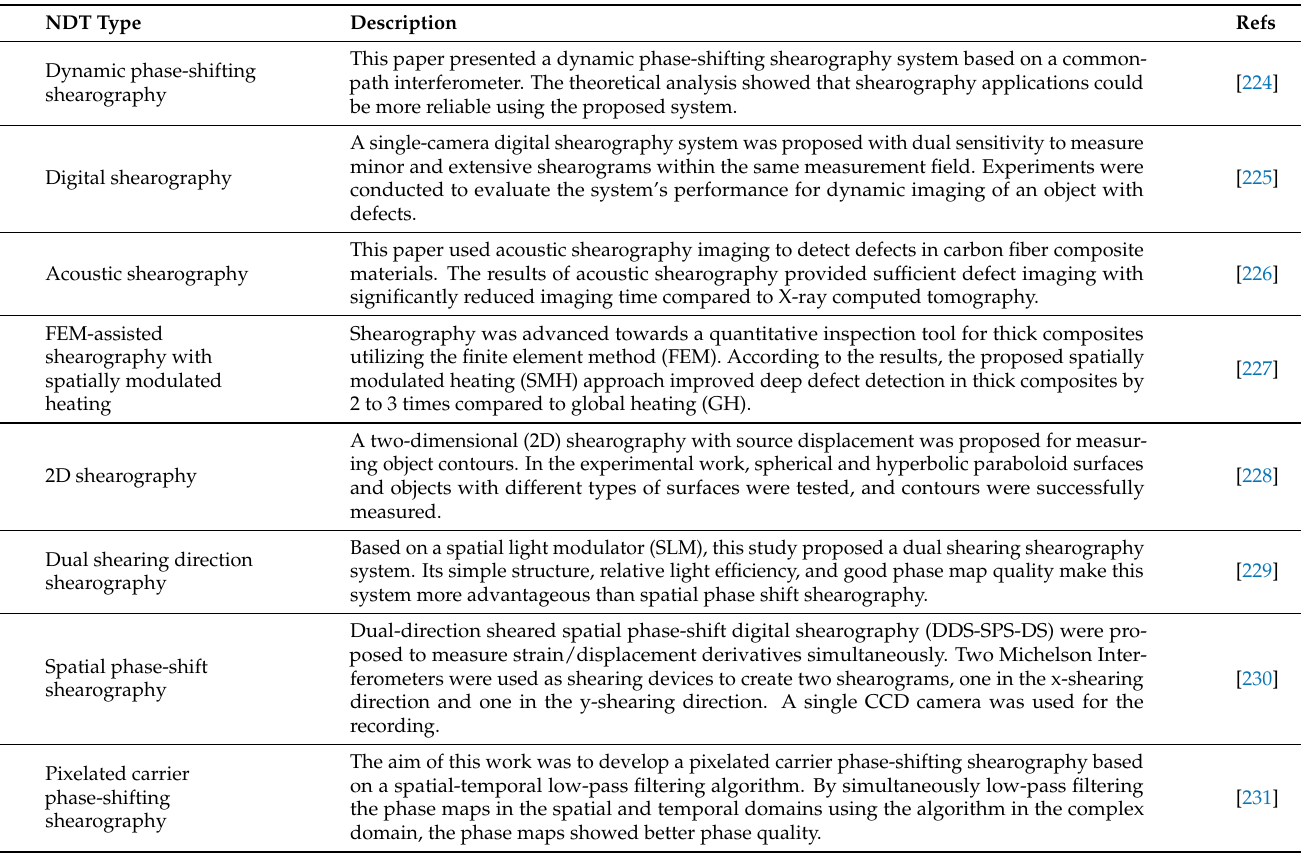
Table 12. Recent papers on shearography NDT